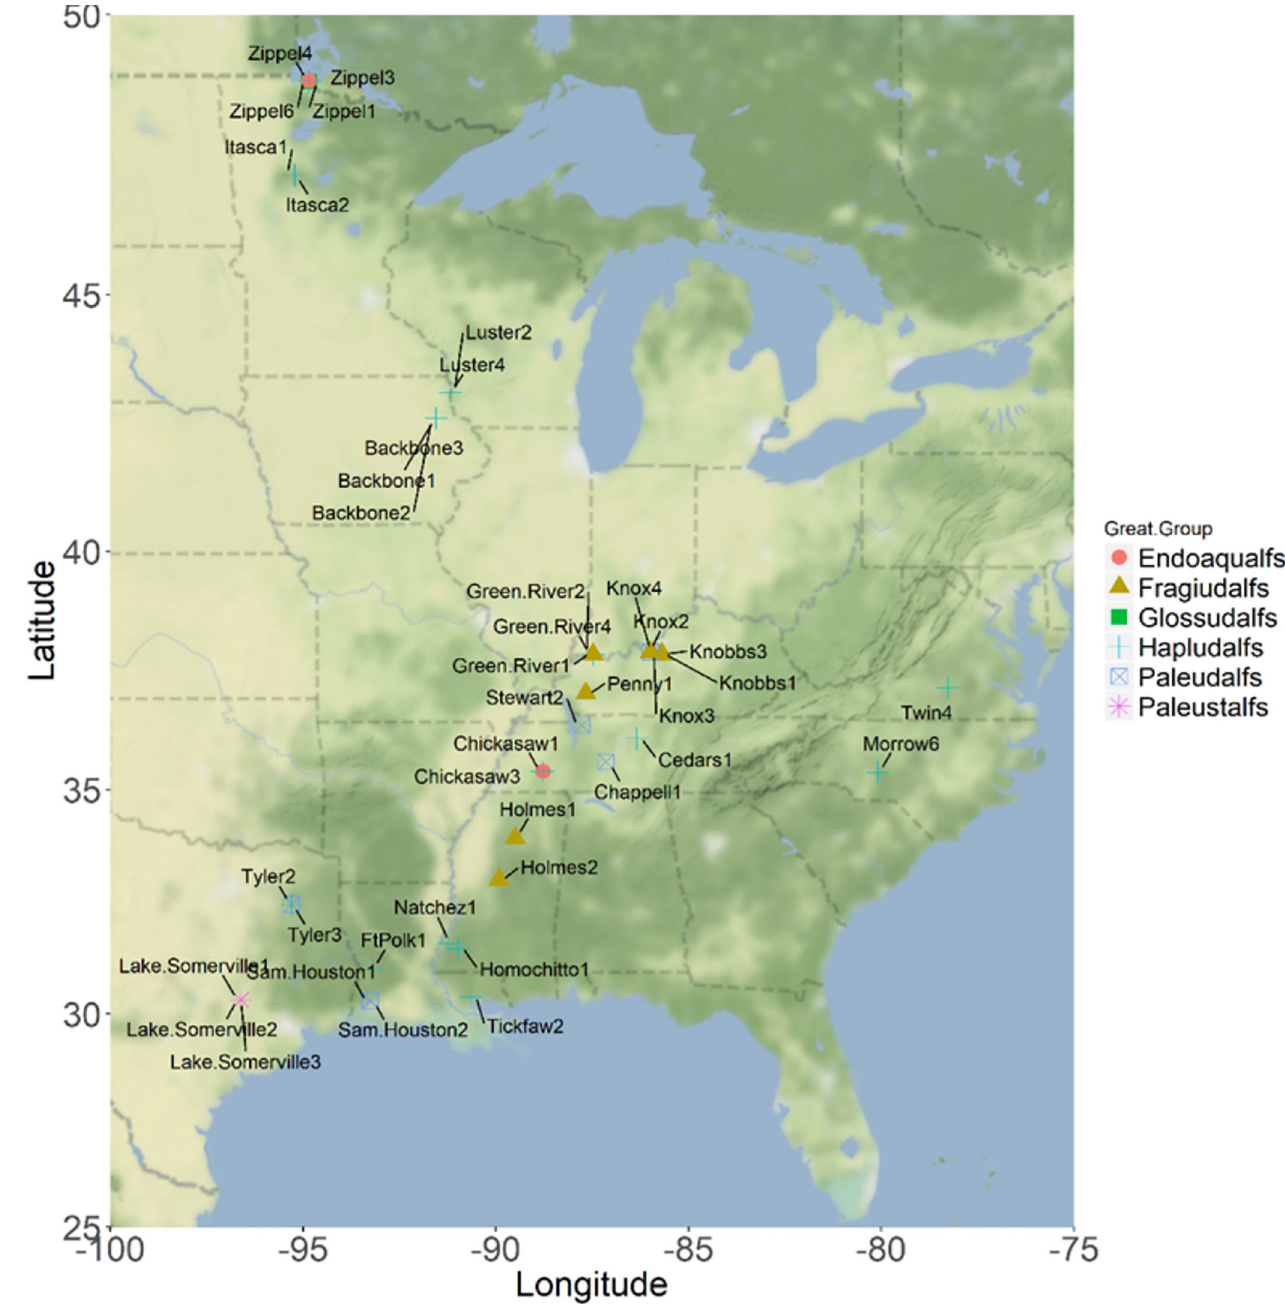
Fig 1. Map showing location of Alfisols collected throughout the Eastern and Midwestern U.S. Location markers are colored with respective to the soils’ NRCS Great Group taxonomic designations. The map was created using the ggmap package [27] for R.